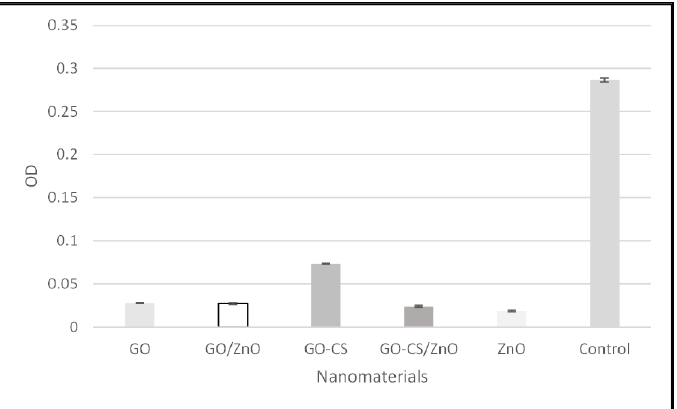
Figure 4. Biofilm inhibitory potential of nanomaterials.